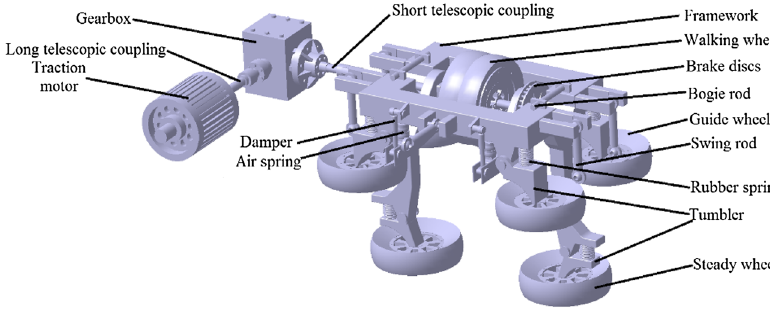
Fig. 4 3D schematic diagram